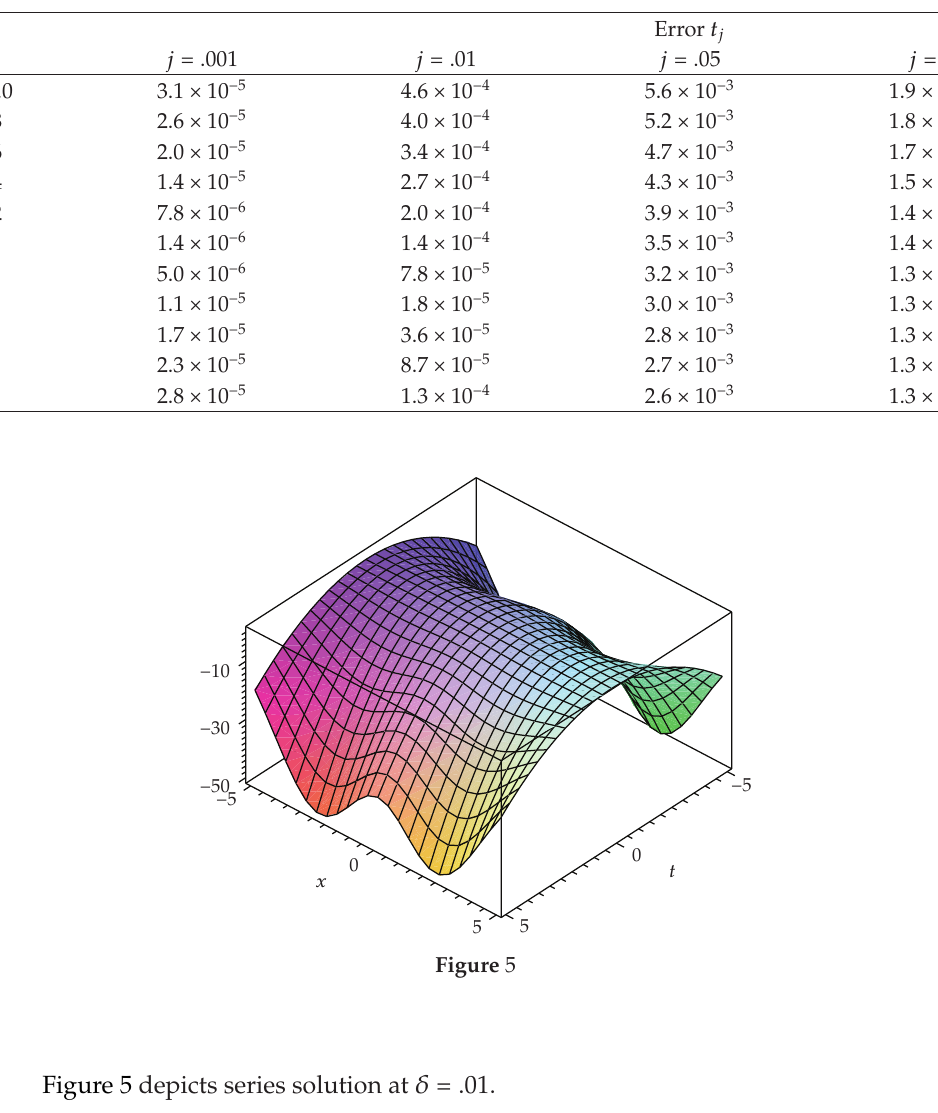
Table 8: Error estimates (cid:3) δ (cid:9) . 01 (cid:4)